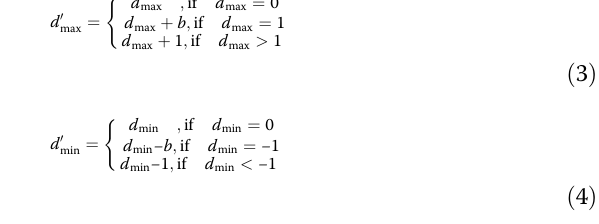
Next, the differences 1 and − 1 are used for hiding the confidential information b . In view of the differences larger than 1 or smaller than − 1, 1 is added to or subtracted from the largest or the smallest pixel value for difference shifting. When the difference is 0, there is no operation. The new pixel values d 0 and d 0 are obtained after accomplishing max min difference shifting according to the conditions above. The steganography equations are given